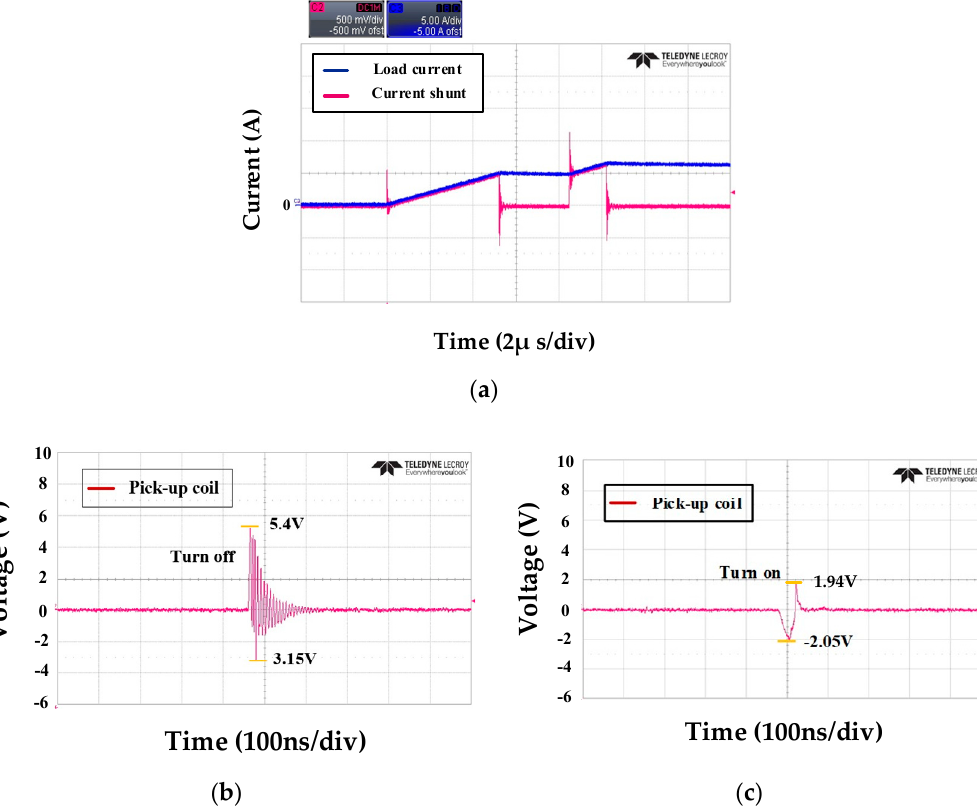
Figure 12. Measured current shunt results and coil output without the integrator following switch behavior: ( a ) current shunt; ( b ) output of pick-up coil during switch-o ff condition; ( c ) output of pick-up coil during switch-on